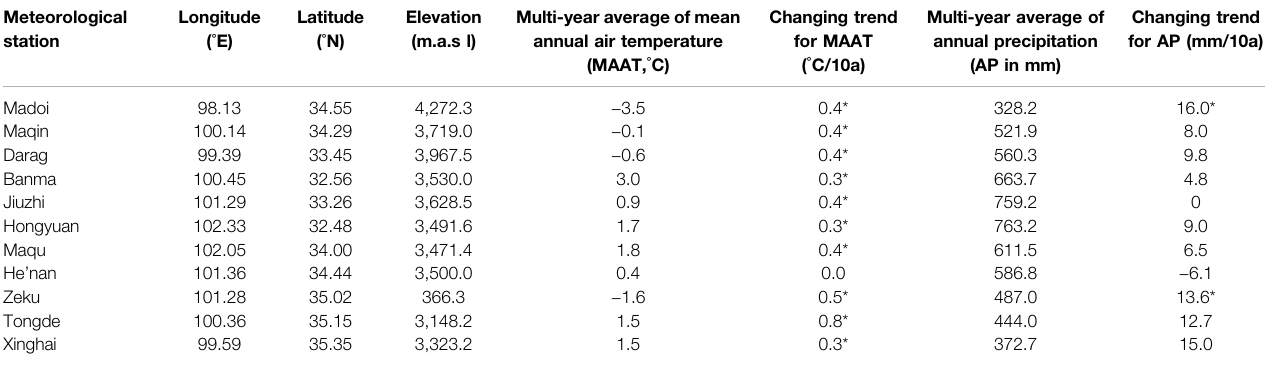
TABLE 1 | Climate changes at the meteorological stations scale in the Source Area of the Yellow River on the northeastern Qinghai-Tibet Plateau in Southwest China from 1961 to 2020. Meteorological